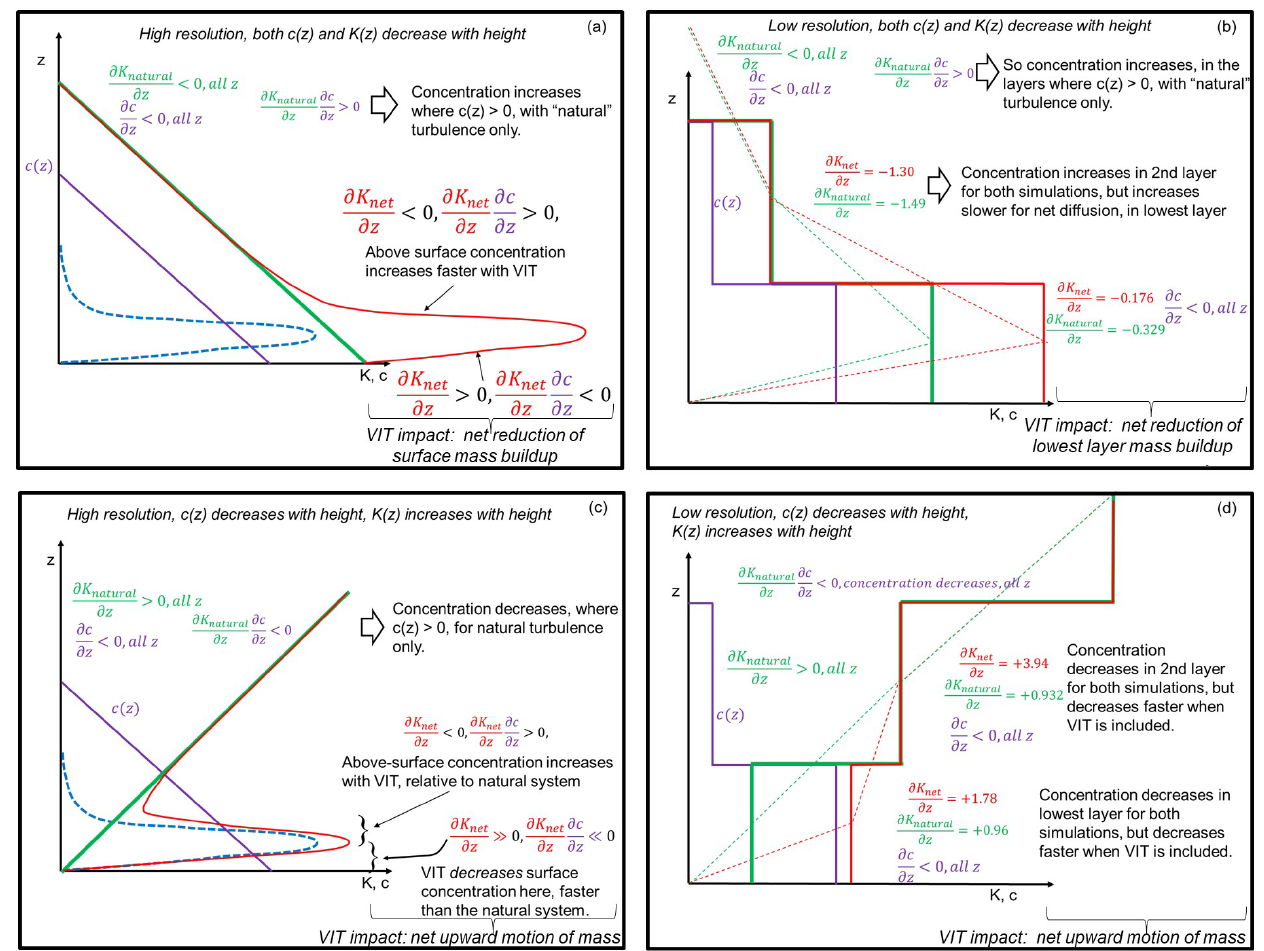
Figure 2. Illustration of the impact of VIT on the local vertical gradient of the thermal turbulent transfer coefficients, at high (a, c) and low (b, d) resolution. Purple, green, dashed blue, and red lines illustrate the height variation in concentration, meteorological, or natural coefficient of thermal turbulent transfer, VIT coefficient of thermal turbulent transfer, and net coefficient of thermal turbulent transfer, re- spectively. (a, b) High- and low-resolution profiles and gradients, for the case where both concentration and meteorological thermal turbulent transfer coefficients decrease with height. (c, d) High- and low-resolution profiles and gradients, for the case where concentration decreases and meteorological thermal turbulent transfer coefficients increases with